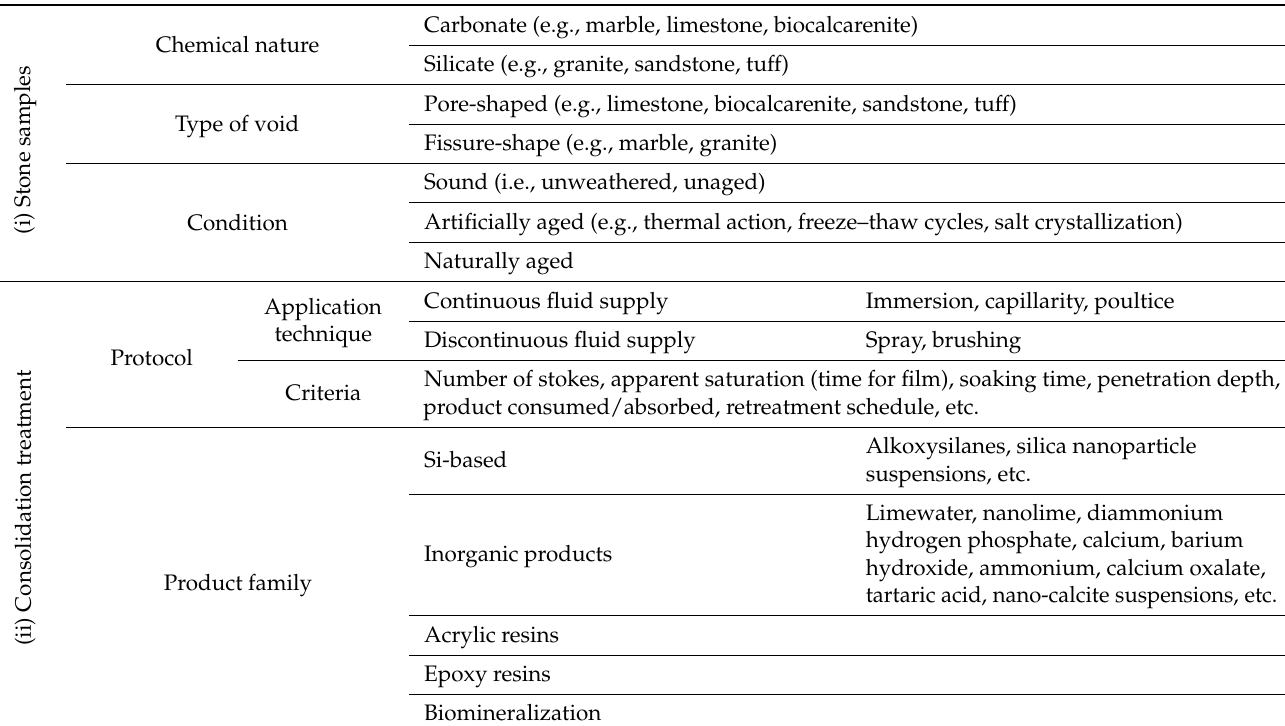
Table 1. Criteria used to analyze the experimental program of research articles regarding the stone sample characteristics (i) and the consolidation treatment details